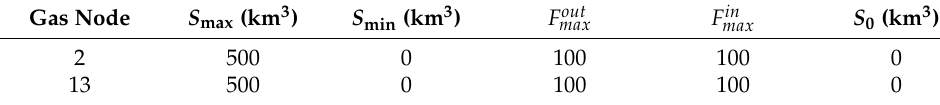
Table A3. Parameters of natural gas storage.